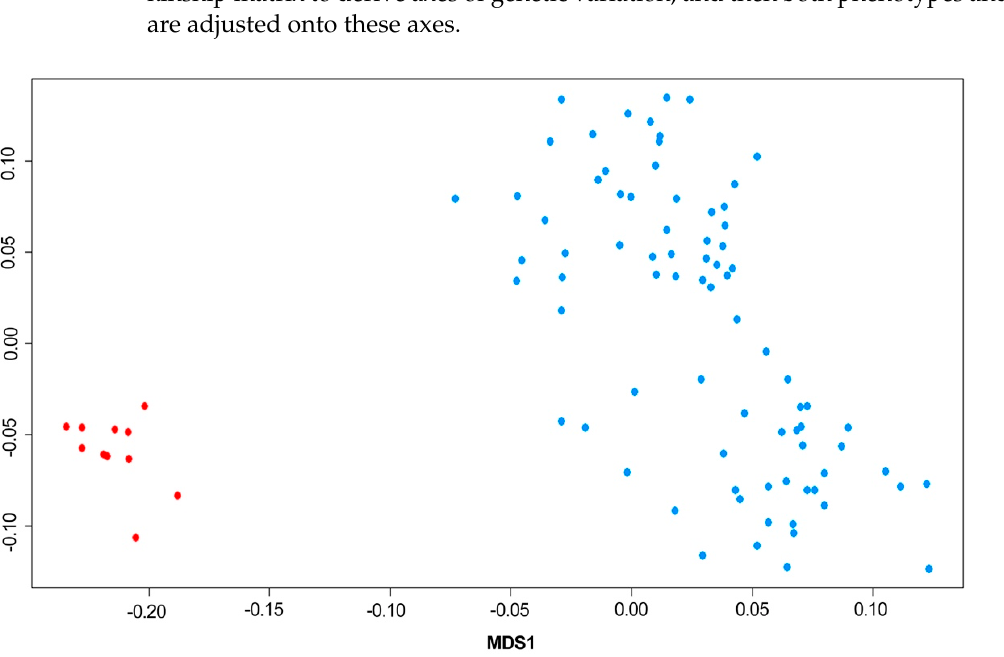
Figure 1. Muldimensional scaling analysis showing population genomic structure in the studied Braunvieh population.